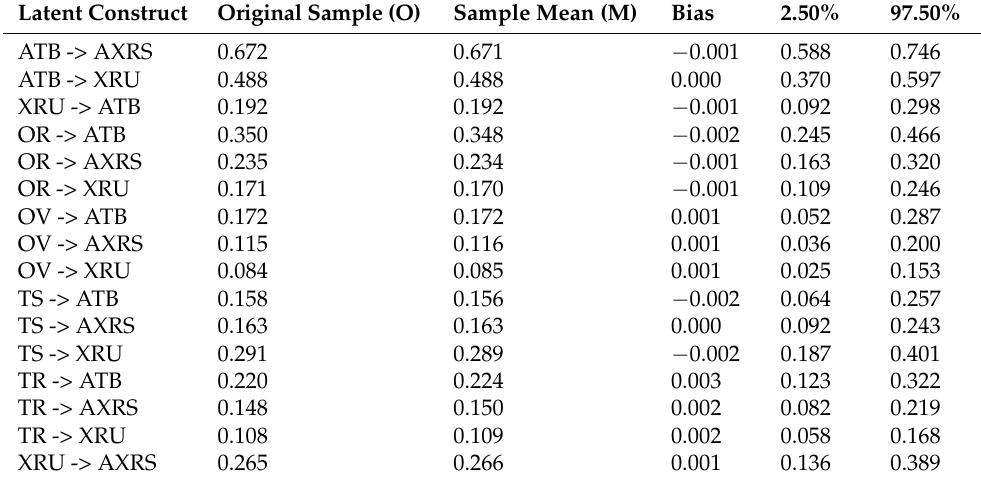
Table 5. Hetero trait–mono trait (HTMT inference).